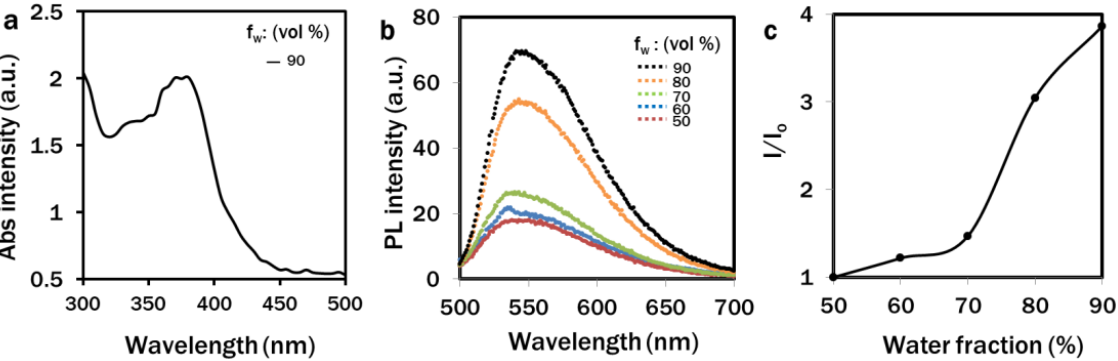
Figure 2. Fluorescence properties of 2-DPAN. Absorption spectra ( a ) and fluorescence spectra ( b , c ) of 2-DPAN (10 µM) in 90% water fraction and DMSO-water mixtures, respectively.